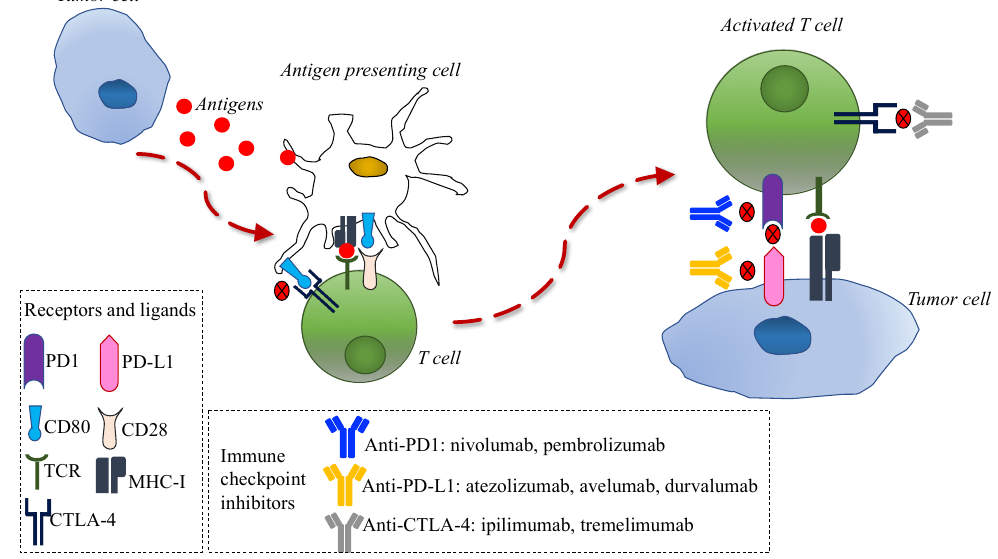
Figure 1. Immune response to tumor cells and main mechanisms of action of anti-programmed cell death 1 (PD-1) / programmed cell death ligand 1 (PD-L1) and anti-cytotoxic T lymphocyte-associated protein-4 (CTLA-4). Tumor cells release antigens that are uptaken by antigen-presenting cells. These cells present tumoral antigens to naïve T-cells, thus activating them. The interaction between PD-1 in activated T-cells and PD-L1 in tumor cells can inhibit the immune response. CD80 on antigen-presenting cells can bind to CTLA-4 on activated T-cells and inhibit the immune response. Anti PD-1 / PD-L1 and anti-CTLA4 monoclonal antibodies can bind to PD-1 in activated T-cells, PD-1 in tumor cells, or CTLA-4 in tumor cells, respectively, thus restoring the immune response.